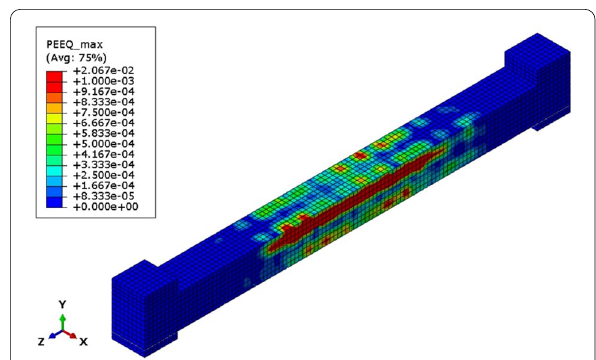
Fig. 28 Equivalent plastic strain in ABAQUS beam.